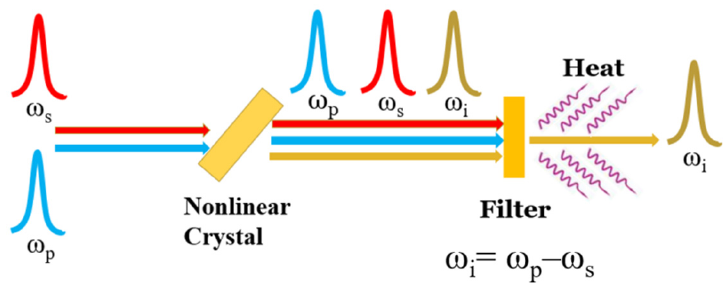
Figure 11. Heat effect during the DFG process.